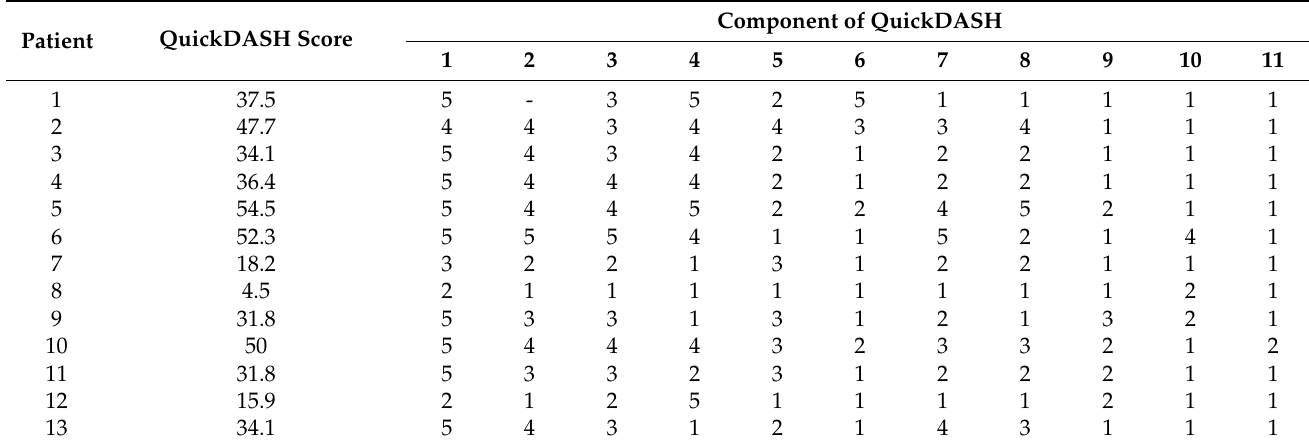
Table 6. QuickDASH score of patients with